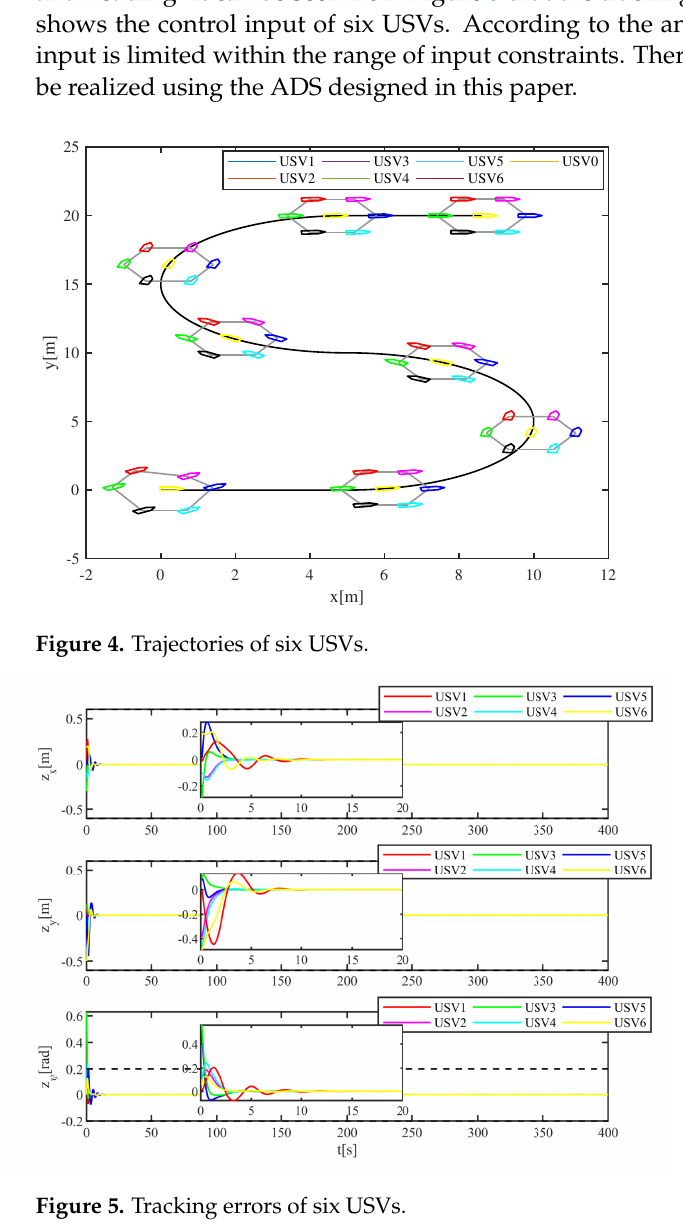
Figure 5. Tracking errors of six